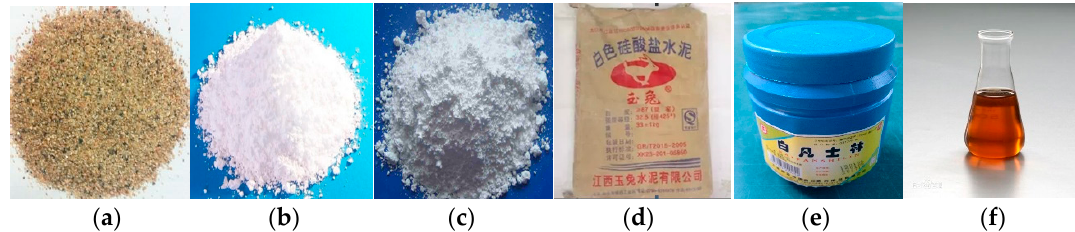
Figure 1. The raw materials of similar-material: ( a ) River sand; ( b ) Calcium carbonate; ( c ) Talc powder; ( d ) White cement; ( e ) Vaseline; ( f ) Antiwear hydraulic